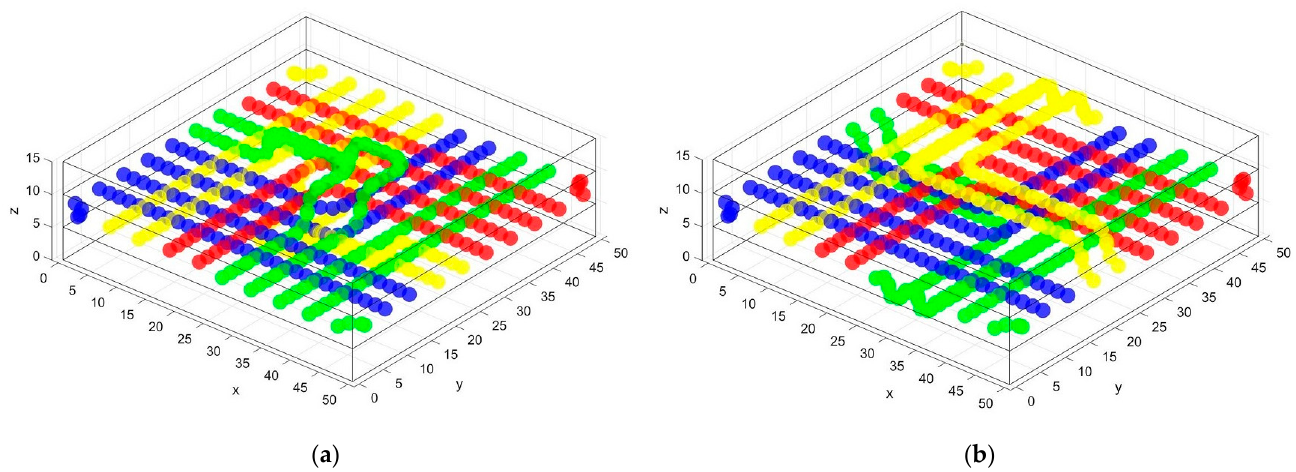
Figure 14. Trajectories of the UAVs scheduled at t i in ( a ) mode 1 and ( b ) mode 2. One UAV is represented by one color and UAVs coming from the same way have the same color.